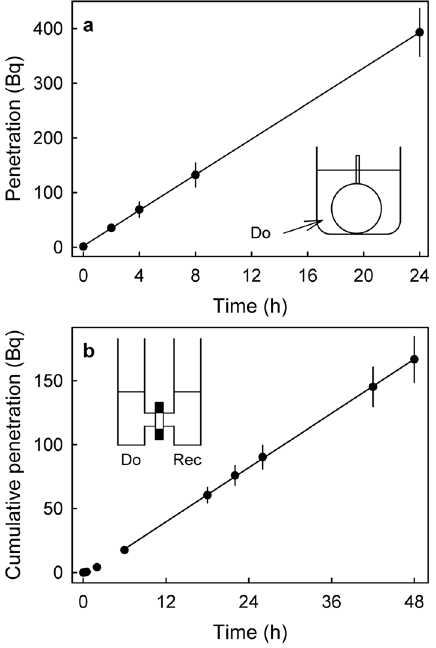
Figure 1. Time courses of penetration of 45 CaCl 2 in sweet cherry. ( a ) Whole fruit incubated in a 45 CaCl 2 containing donor solution. Inset: Sketch of a sweet cherry fruit incubated in 45 CaCl 2 . ( b ) Cumulative penetration from a donor (Do) solution containing 45 CaCl 2 through an excised skin segment into a receiver (Rec) solution. Inset: Sketch of an infinite diffusion